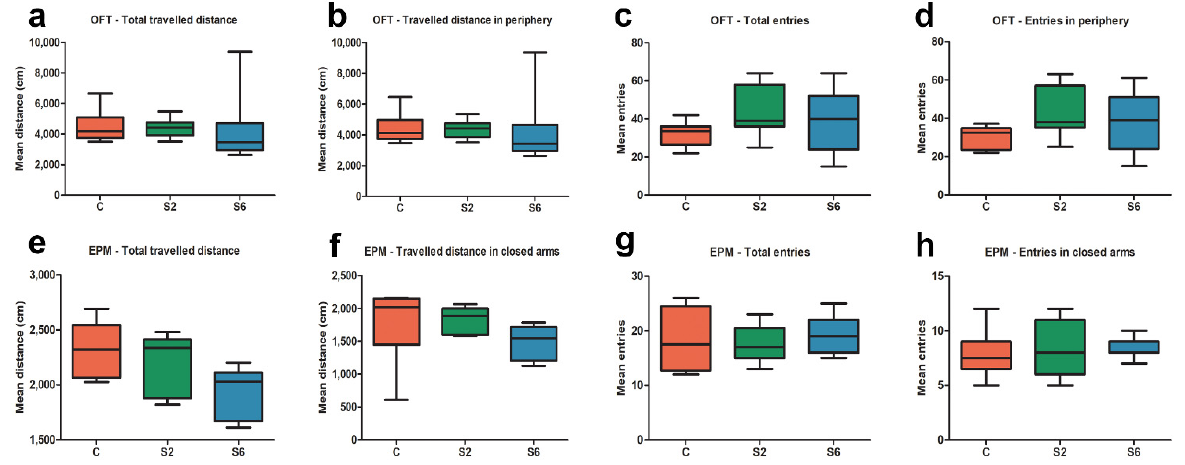
Figure 3. The effects of restraint stress on total ( a , e ) and peripheral ( b , f ) traveled distance and the total ( c , g ) and peripheral ( d , h ) number of entries in the open field test (OFT) and elevated plus maze (EPM) test. The restraint stress exerted no significant effects on general locomotion in OFT and EPM tests ( p > 0.05) ( a – h ). Each group consisted of 10 rats. The bottom and top of the box are the first and third quartiles and the whiskers above and below the box indicate the 95th and 5th percentiles. The median is indicated as a horizontal line. The experimental groups were distributed on the X axis. The Y axis was used to expose the measuring unit for the test.